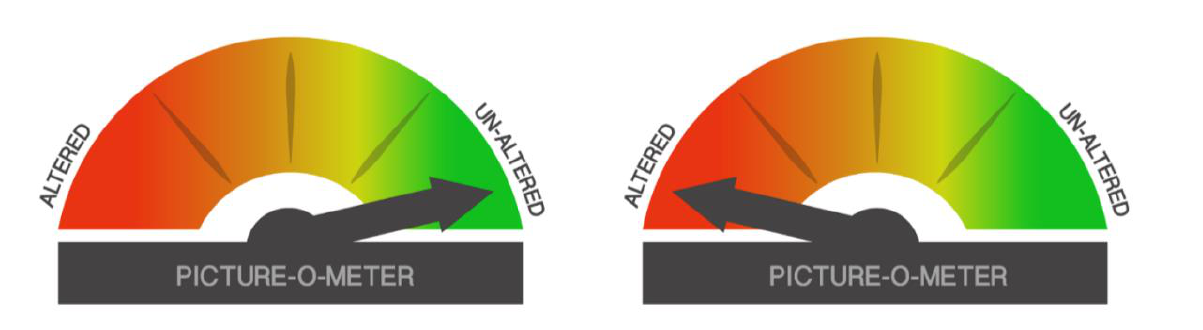
Figure 6. Picture-O- Meter showing the “Un - Altered” and “Altered” forensic